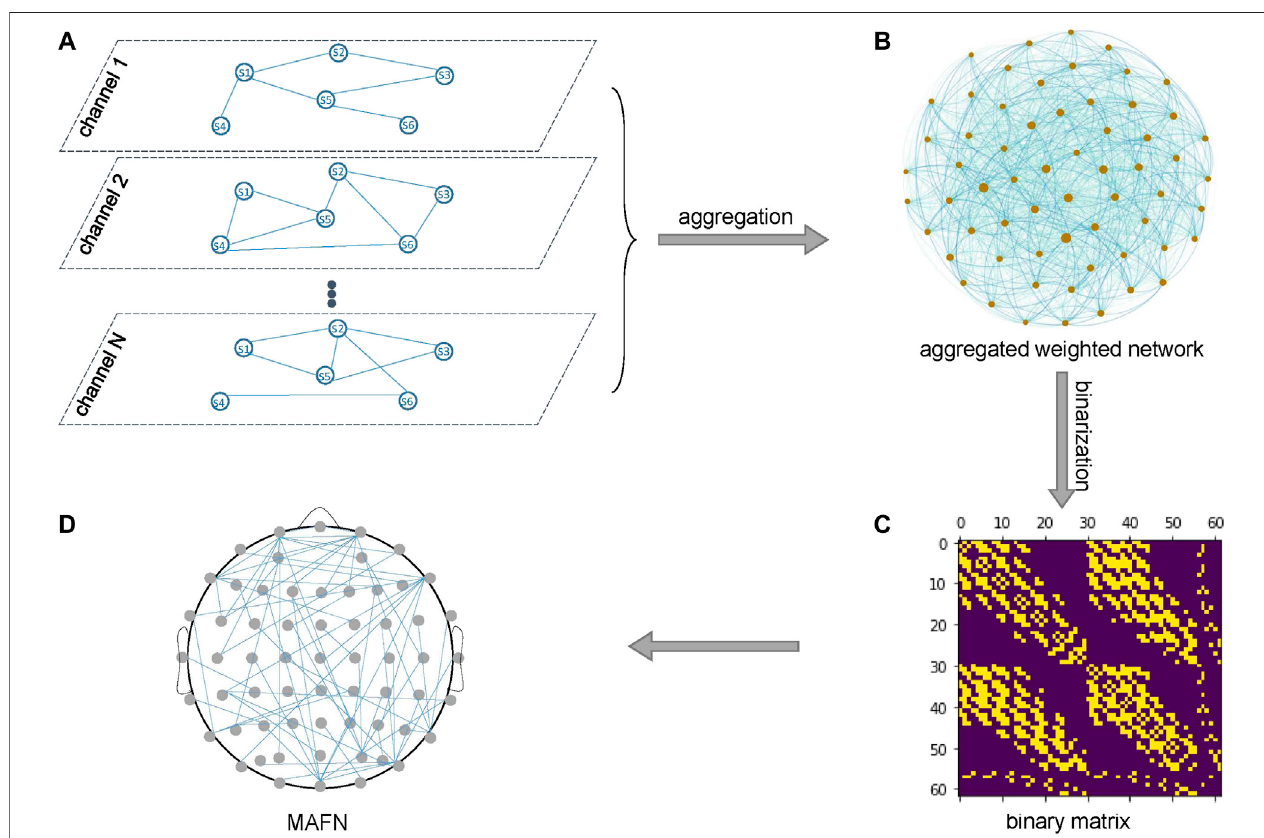
FIGURE2| Aggregationofthelayersofallchannels. (A) Theindividuallayersof N channelsand (B) anaggregatedweightednetworkoftheselayers. (C) Thebinary matrix for the MAFN in (D) .